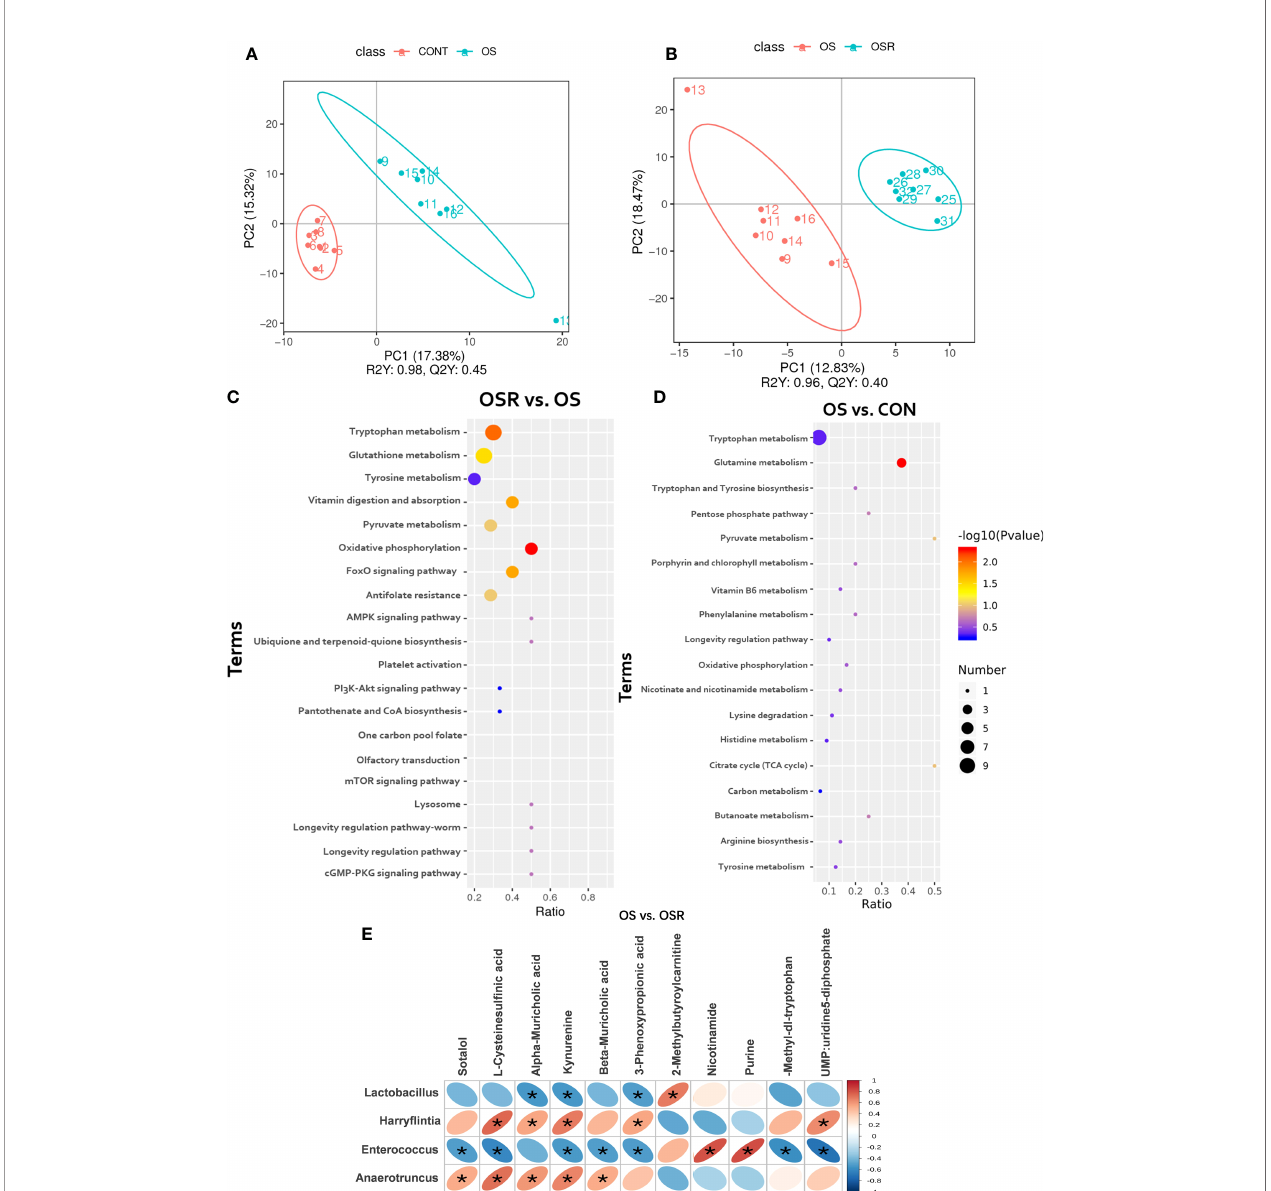
FIGURE 7 | Dietary resveratrol supplementation alleviated the oxidative stress (by tBHP) induced changes in serum metabolites (Exp.1). (A, B) The principal component analysis (PCA) of the serum metabolites between OS vs. CON (A) , and between OSR vs. OS group (B) . (C, D) KEGG pathway enrichment of target metabolites between OS vs. CON (C) , and between OSR vs. OS group (D) . (E) Spearsman correlations between metabolites and cecum microbiota. Statistical signi fi cance was evaluated by the Student ’ s T-test, * p <